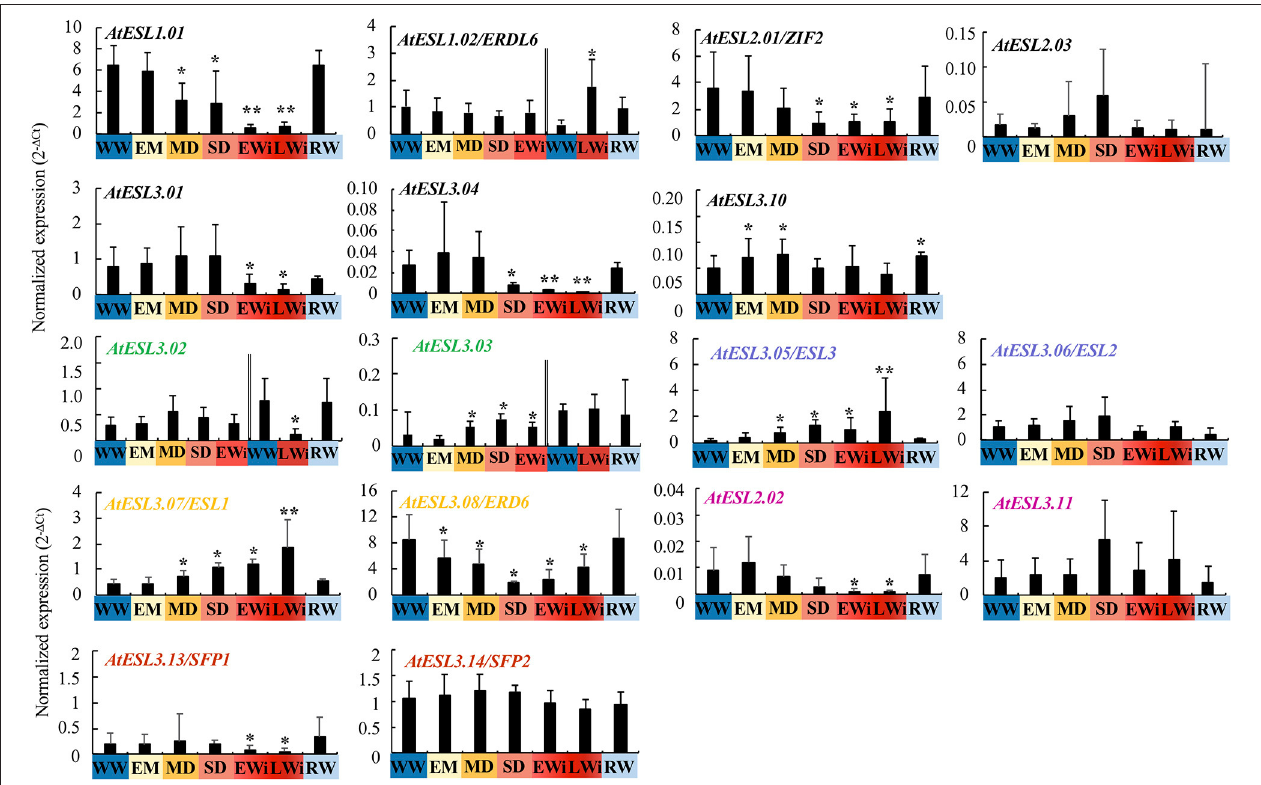
FIGURE 5 | Relative expression of 17 AtESL in A. thaliana Col-0 in WW, WD, and RW plants as the function of the four phases of water deficit: EM, early mild water deficit; MD, moderate water deficit; SD, severe water deficit; EWi, early wilting; LWi, late wilting. The 2 − 1 Ct values are normalized according to AtPP2a expression. On the left of the double bar, the level of gene expression does not show any significant variation during the growth kinetic under WW conditions: the gene expression in EM, MD, SD, and EWI phases is compared to the mean value measured under WW condition during these periods. On the right of the double bar, the gene expression being significantly different at the end of the growth kinetics (49–50 dps): the gene expression in LWi and RW is compared to that observed under WW conditions those late developmental phases. The study was carried out with five plants per condition and three independent biological repeats were performed ( ± SD). The asterisks represent the significantly different values determined by the Kruskal–Wallis test followed by Dunn’s multiple comparisons test (* p < 0.05; ** p < 0.001) with the Bonferroni